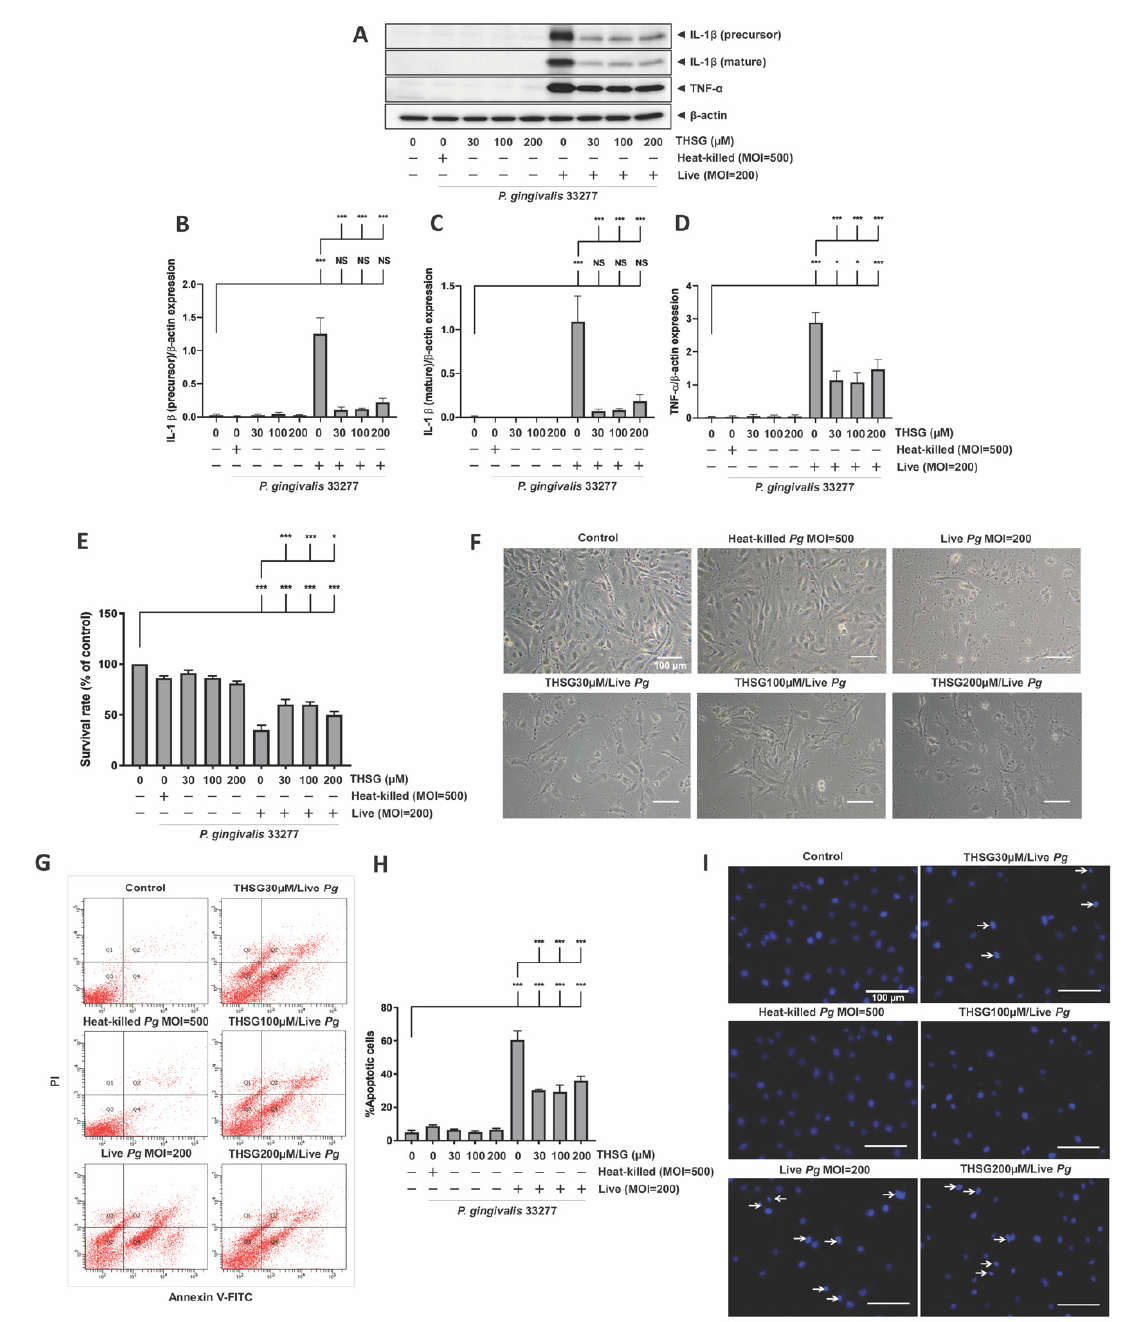
Figure 5. THSG possesses anti-inflammation and antiapoptosis in P. gingivalis -infected primary brain endothelial cells. MBECs were pre-incubated for 2 h with THSG (0, 30, 100, 200 μ M) before 90 min P. gingivalis stimulation (heat-killed MOI 500, live MOI 200). After 24 h of additional incubation, the expression of IL-1 β (precursor), IL-1 β (mature), and TNF- α proteins were determined by Western blotting ( A ). The quantitative results are shown in ( B – D ). ( E ) The survival rate in a percentage of control was investigated using MTT assay. ( F ) Cell morphology was observed under a light microscope. MBECs were treated with THSG for 2 h and infected with P. gingivalis ; apoptotic cells were determined by Annexin V/PI staining ( G , H ) and DAPI staining ( I ). All data are presented in mean value ± SEM (n = 4). *, p < 0.05; ***, p < 0.001; NS (not significant.), p > 0.05 were compared with control group and THSG 0 μ M group. A scale bar is 100 μ m in ( F , I ).